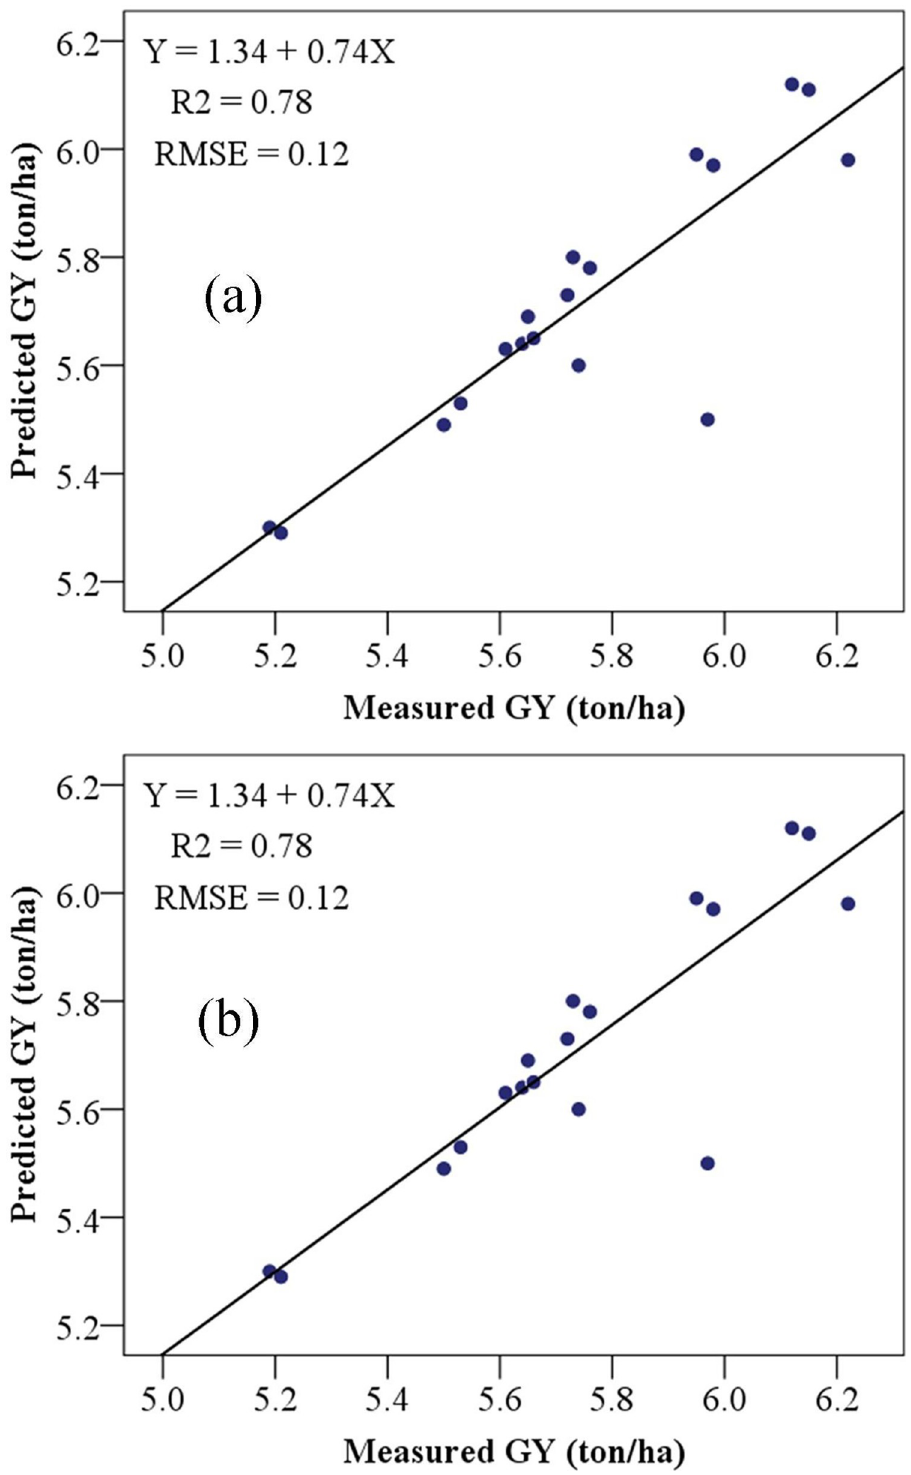
Fig 9. Scatter graphs illustrating maize model validation results from combined models. (a), ABY and (b), GY. ABY aboveground biomass, GY grain yield, R 2 coefficient of determination, and RMSE, root mean square error.